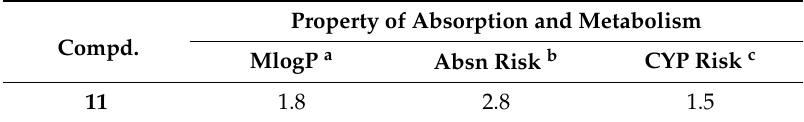
Table 5. Absorption and metabolism property of compound 11 . Property of Absorption and Compd.